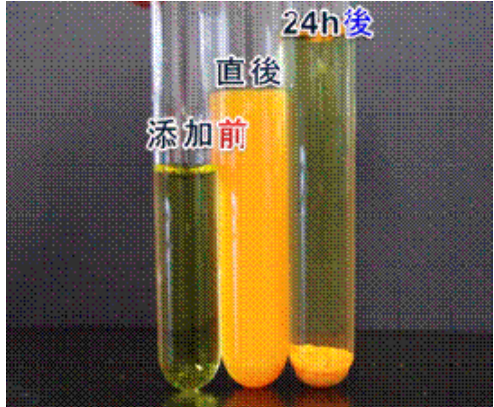
Figure 30. Photographs of the antimony sulfide precipitate formed when a trace Na 2 S was added to a solution of Sb(III) and Zr(IV) eluted from Zr(IV)-loaded SOJR gel using 1 M HCl. Left: before Na 2 S was added, center: just after Na 2 S was added, right: 24 h after Na 2 S was added. [27]. (With permission for reuse from Elsevier B.V.).